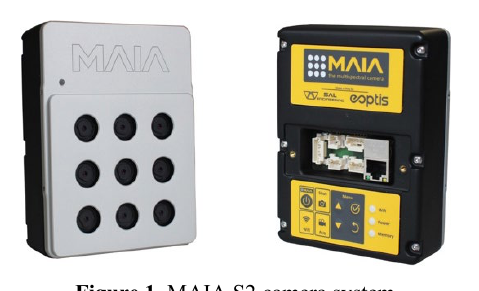
Figure 1 . MAIA S2 camera system